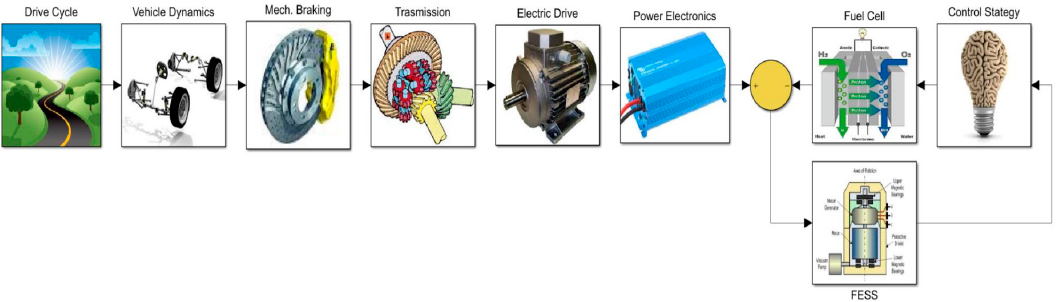
Figure 3. Sketch of the mathematical model of the system.